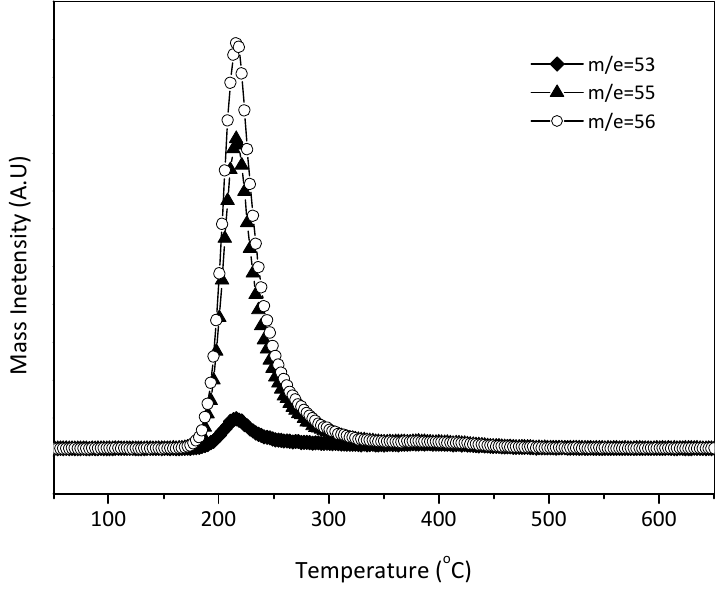
Figure 1. The glycerol desorption in TPSR of SAPO-11 (M/e = 61).